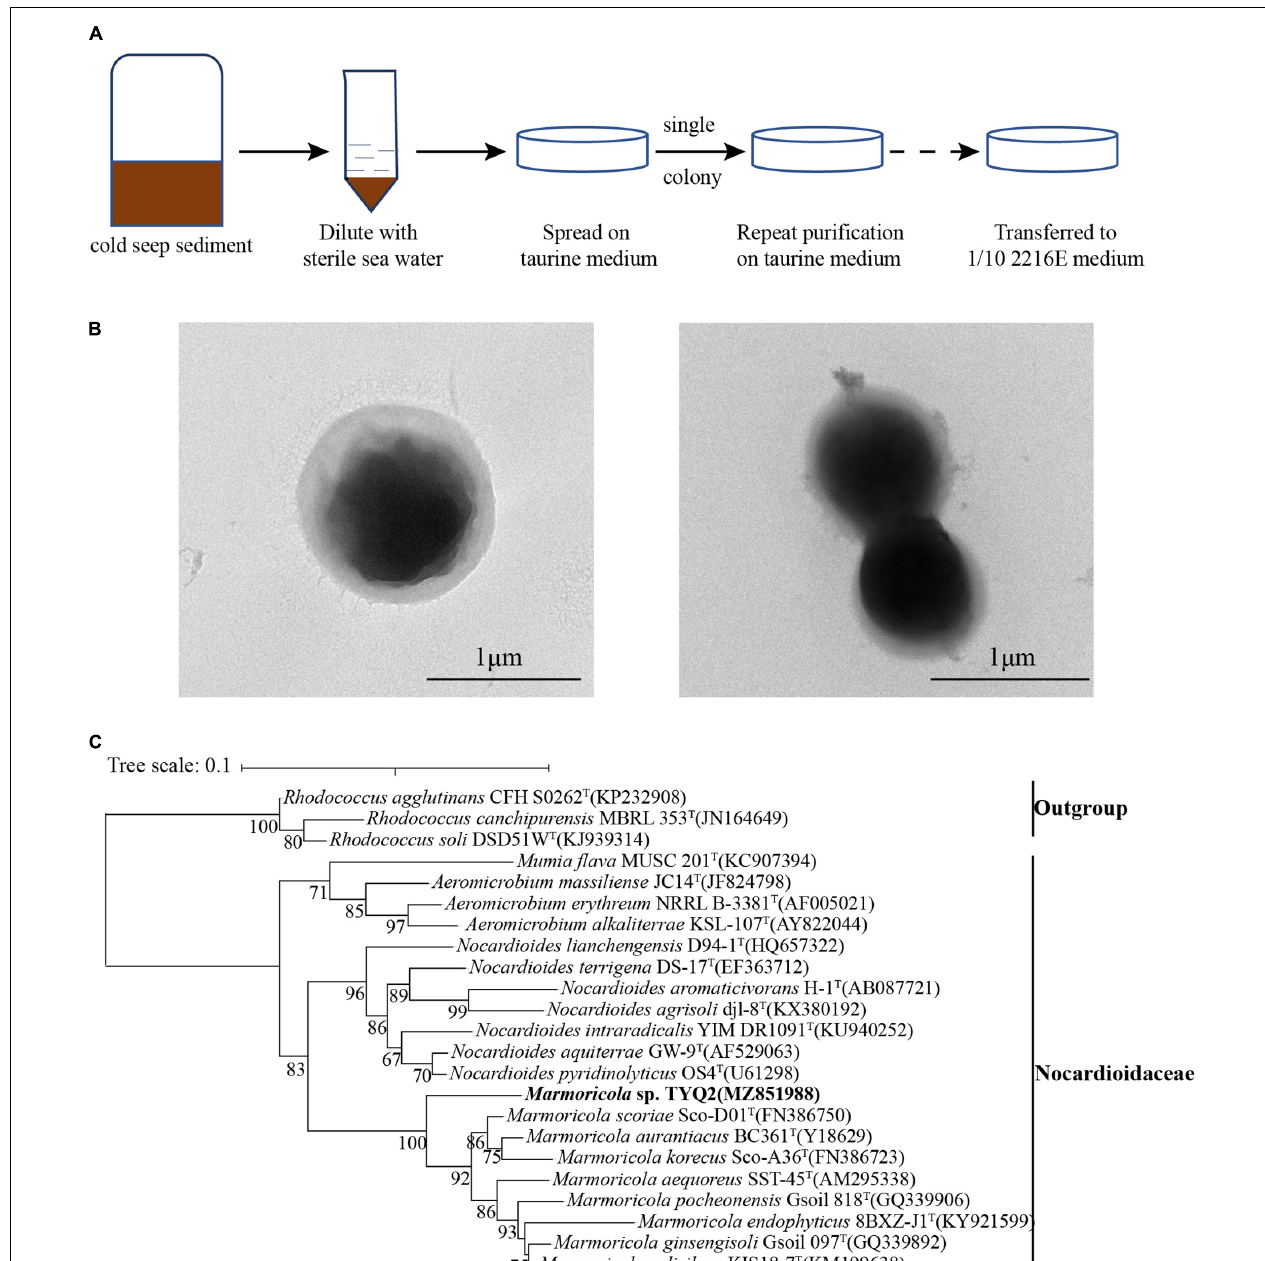
FIGURE 1 | Cultivation, morphology, and phylogeny of Marmoricola sp. TYQ2 isolated from the deep-sea cold seep. (A) Diagram of enrichment and cultivation of strain TYQ2 by using a taurine supplemented medium. (B) Observation of the cell morphology of strain TYQ2 through the transmission electron microscopy. Bar is 1 µ m. (C) Maximum likelihood 16S rRNA gene phylogenetic tree showing the position of strain TYQ2 as well as the family Nocardioidaceae within the Actinobacteria phylum. The accession number of each 16S rRNA gene is shown in the parentheses after corresponding strain name. The numbers by the side of branch node indicated statistical support for bootstrap values, respectively. Scale bar, 0.1 substitutions per nucleotide position.